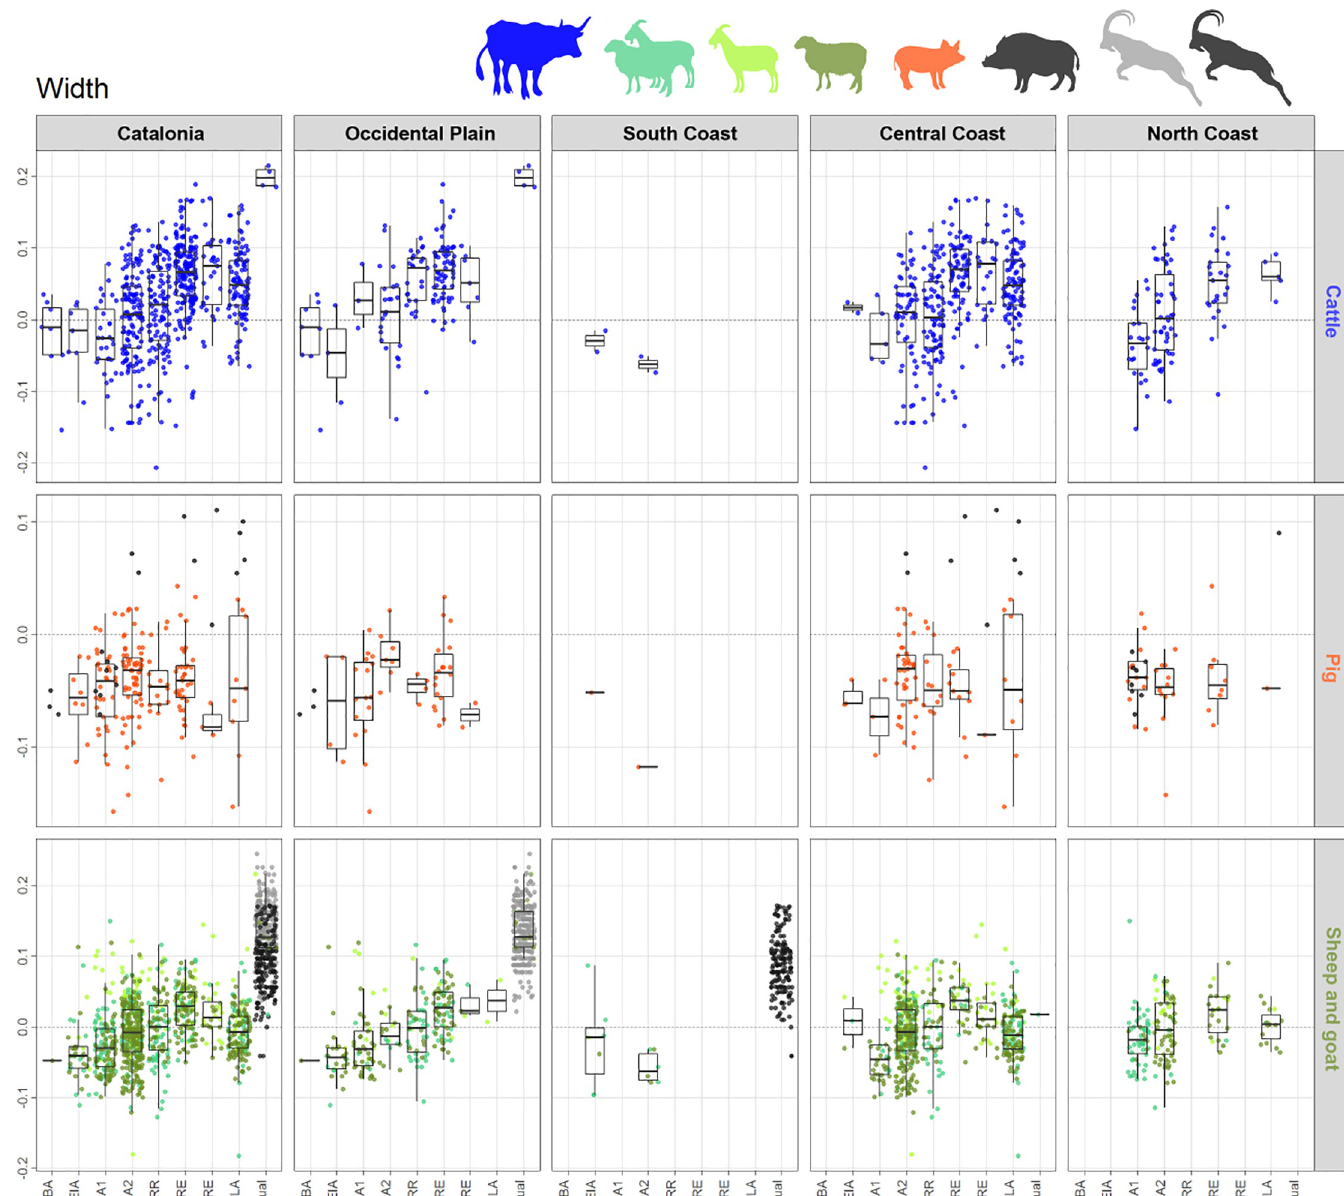
Fig 8. Width LSI values distribution diagram of cattle, pig and sheep/goat bones, by species (in rows) and geographical areas (in columns). Sheep and goats are considered together. For each cell of the diagram, LSI values are displayed on the y-axis and chronological periods on the x-axis: LBA: Late Bronze Age, EIA: Early Iron Age, MIA1: Middle Iron Age 1, MIA2: Middle Iron Age 2, RR: Roman Republic, ERE: Early Roman Empire, LRE: Late Roman Empire, LA: Late Antiquity. Boxplots quartiles measures only represent statistics on main domestic, i.e. wild individuals values are displayed but excluded from statistics. Wild individuals: wild boar (black points), actual Capra pyrenaica hispanica (black points), modern Capra pyrenaica pyrenaica (grey points) [15]; actual Xisqueta breed sheep and Catalan goat breed.